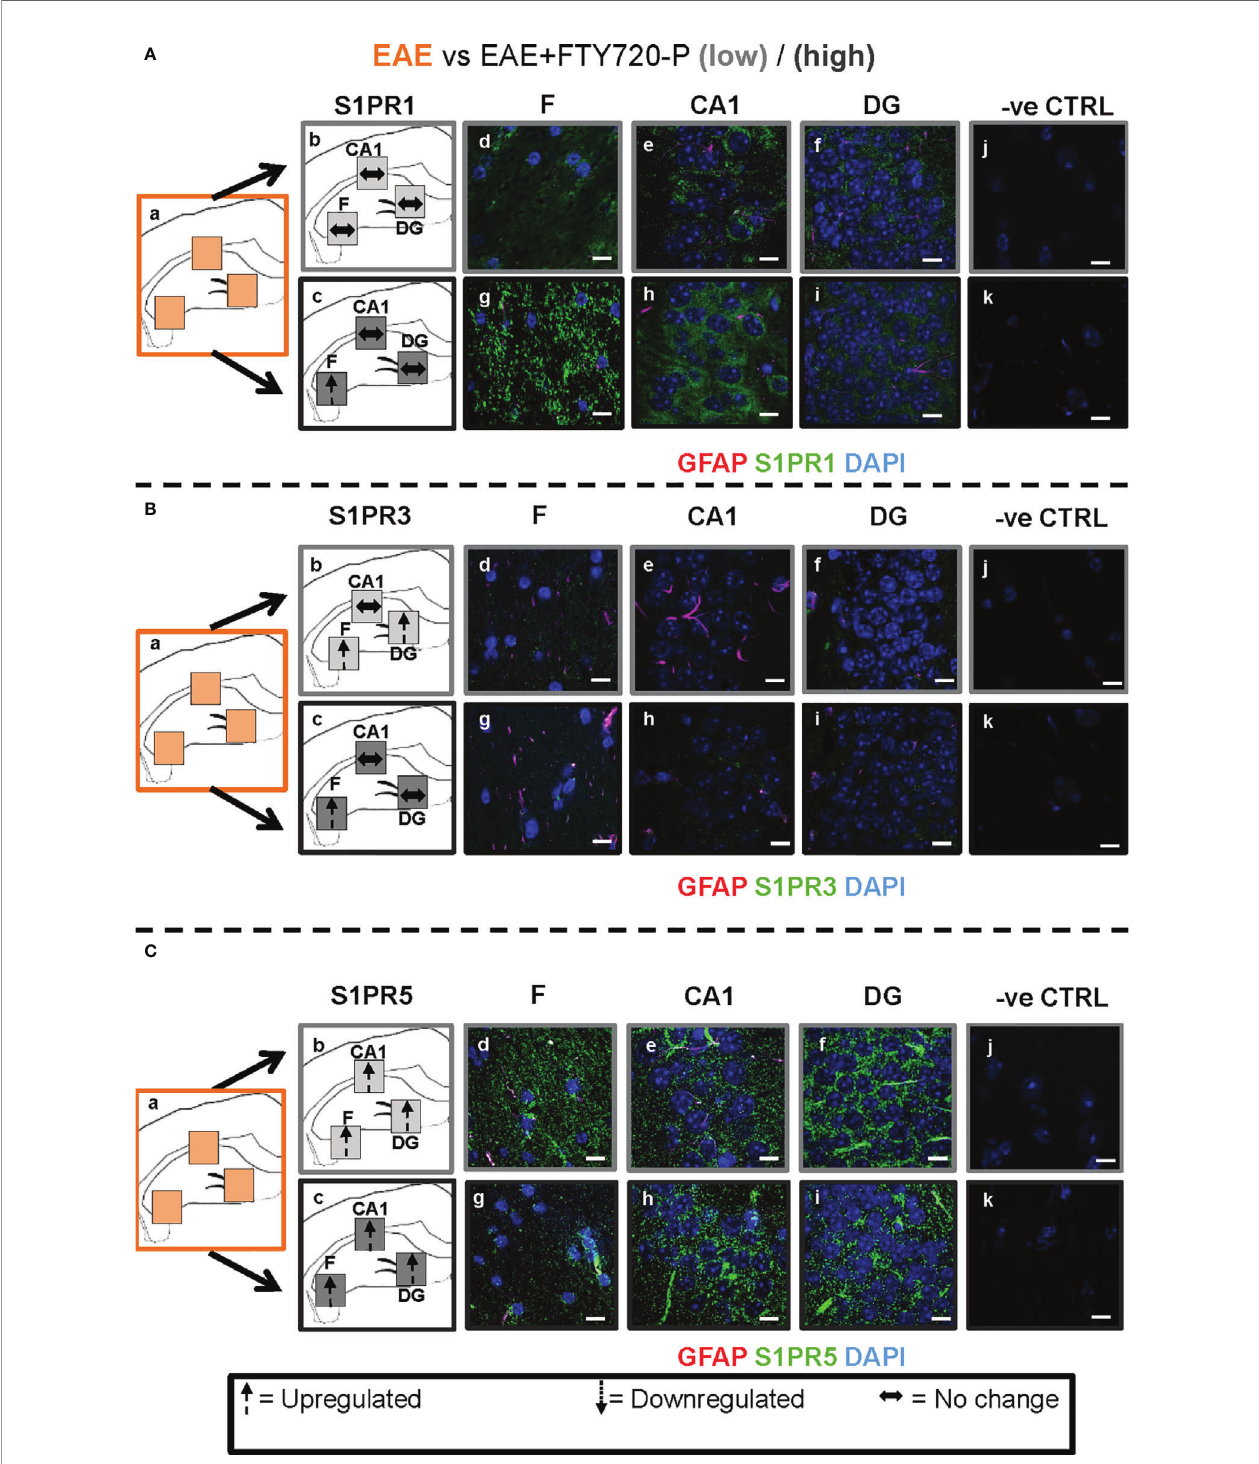
FIGURE 6 | Combined EAE and FTY720 effects on S1PR1, S1PR3 and S1PR5 expression in the hippocampus. Comparison of S1PR expression between EAE, EAE+FTY720-L and EAE+FTY720-H groups. The left-hand panel shows the regions of interest (Aa-c, Ba-c, Ca-c) and the direction of change in three hippocampal sub- fi elds for each S1PR (downregulation = dotted arrow, upregulation = dashed arrow, or no change = horizontal arrow). The main panel shows immunostained sections with anti-GFAP (red) and anti-S1PR1 (green; Ad-f, g-i ), anti-S1PR3 (green; Bd-f, g-i ) or anti-S1PR5 (green; Cd-f, g-i) ; nuclei were stained with DAPI. Original images for Aa, Ba and Ca are found in Figure 4 . No primary antibody controls are shown in Aj-k, Bj-k and Cj-k ). N = 4 mice/group × 6 sections/mouse. Scale bars = 10 µm. Experiments were replicated 3 times. Quanti fi cation of images is shown in Figure 7